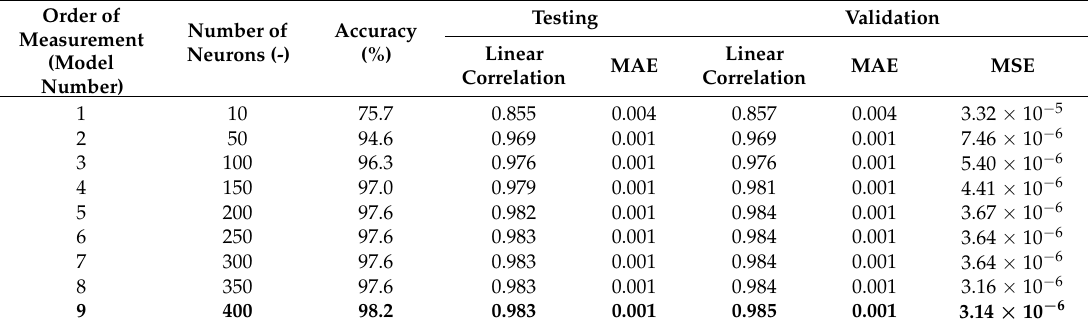
Table 3. The trained models—6 th of May 2018 to 13 th of May 2018.